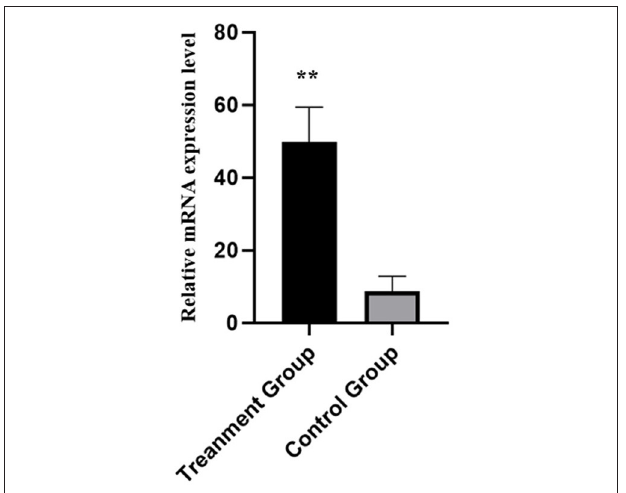
FIGURE 8 | Relative mRNA expression levels of pig NR5A2 gene in ovaries between rpFSH treatment group and the control group ( n = 5). **indicate significant differences ( P <